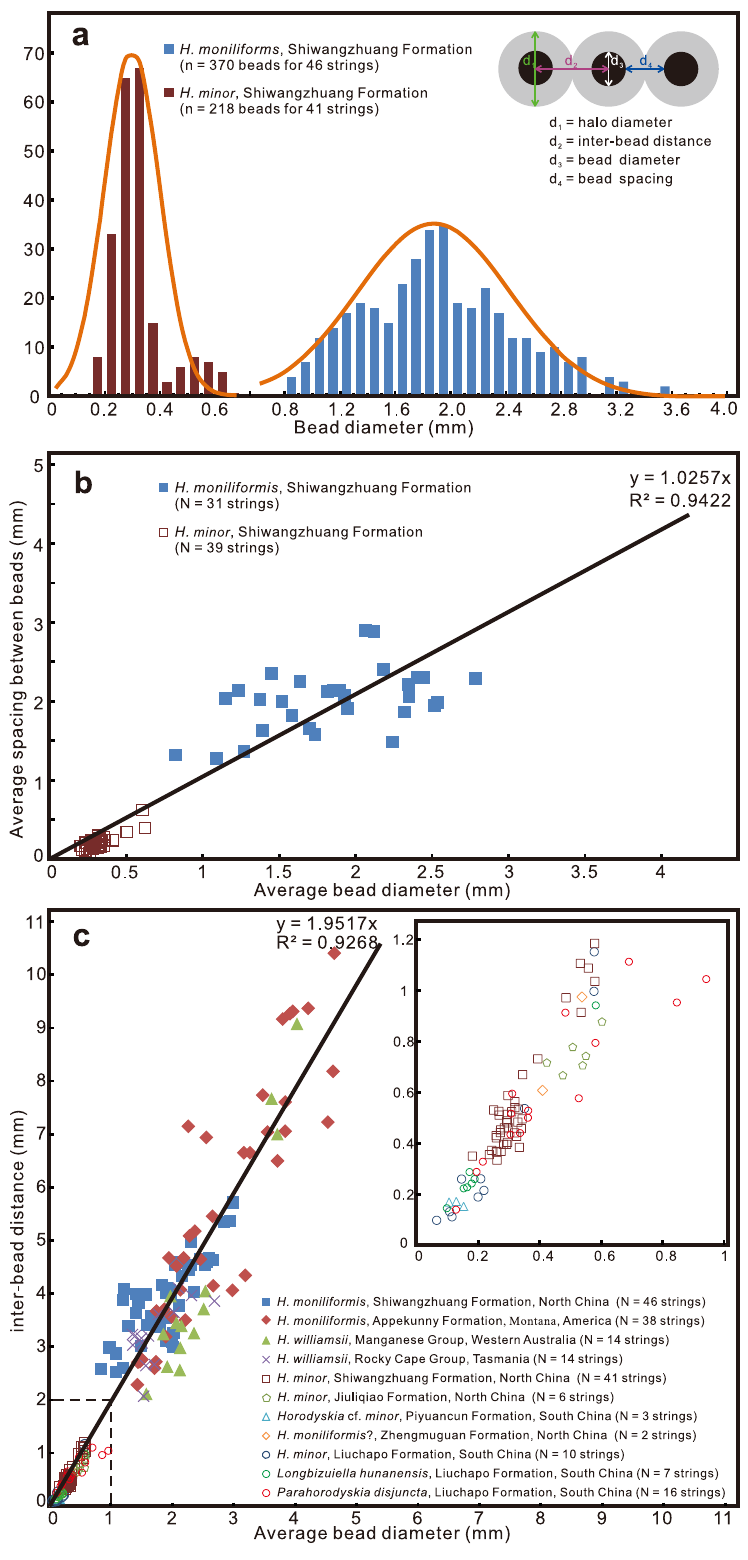
on their observation of material from the early Mesoproterozoic Appekunny Formation. However, microbial mat fragments tend to be irregular in shape and their sizes would likely follow a power-law distribution 31 . In contrast, Horodyskia beads from the Shiwangzhuang Formation show a bi-modal size